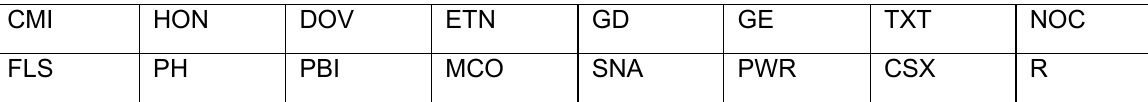
Table: S&P500 Ticker Symbols of the Accrual Firms